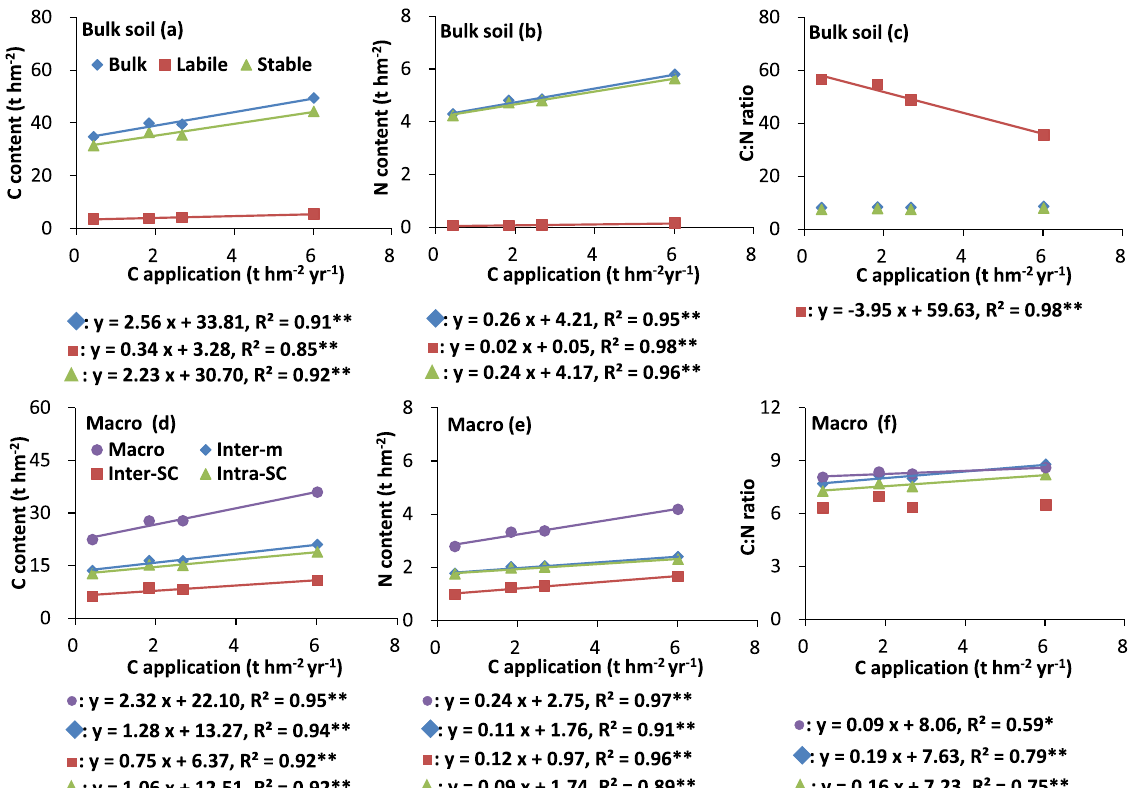
Figure 6. Relationships between carbon inputs and carbon stocks in different fractions above 40 cm soil depth in different treatments. Values are the mean of three replicates. Carbon input sequence on the x-axis is as follows: CK, NPK, 2NPK, and MNPK treatments. * and ** indicate significant difference at P < 0.05 and P < 0.01, respectively. R 2 value was calculated using all the replicates of treatments. See footnote of Table 1 for abbreviations for aggregate